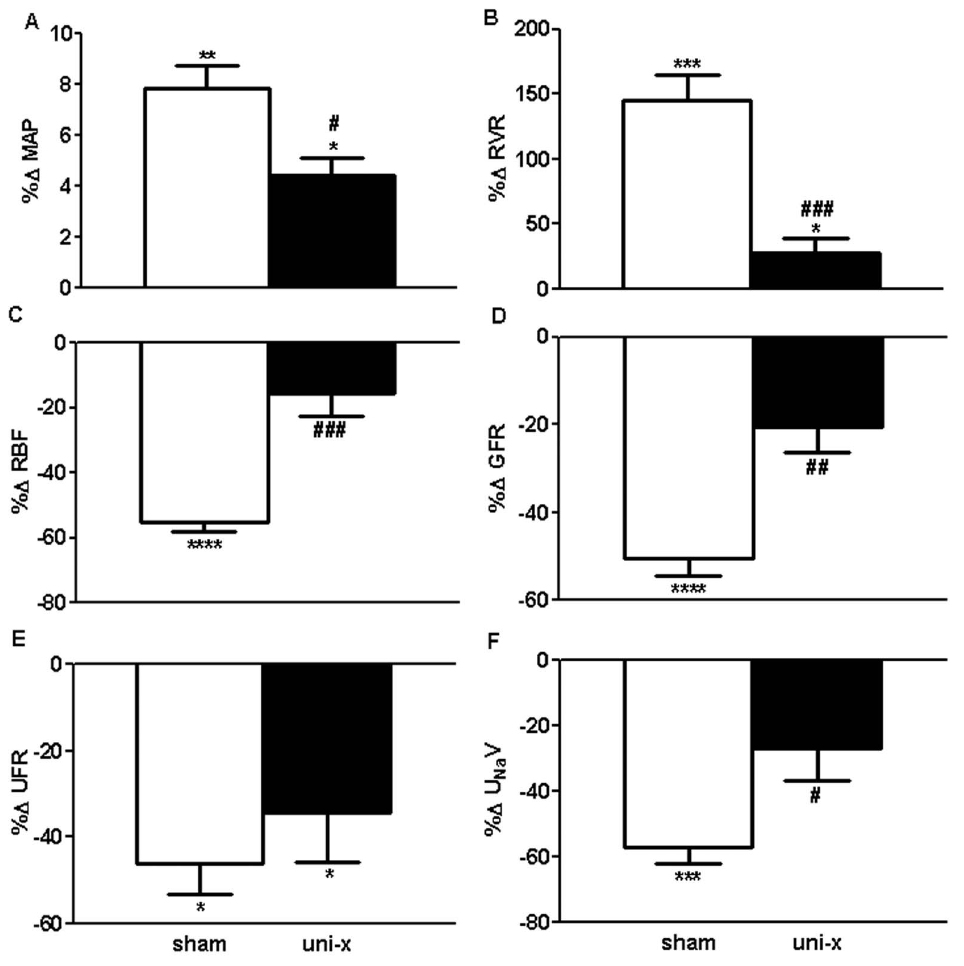
Figure 1. Cardiovascular and renal responses to intravenous infusion of low pressor dose angiotensin II (AngII) expressed as percentage change (% D ) from basal period 1 in sham and uni-x female sheep at 5 years of age (n=5/group). MAP, mean arterial pressure; RVR, renal vascular resistance; RBF, renal blood flow; GFR, glomerular filtration rate; UFR, urine flow rate; U Na V, urinary sodium excretion; all values except MAP are corrected for total kidney weight (gkw). Sham: white bars, uni-x: black bars, *P , 0.05, ***P , 0.001, ****P , 0.0001 from Bonferroni post-hoc test comparing responses of sham or uni-x animals to AngII infusion from their basal period 1. # P , 0.05, ## P , 0.01, ### P , 0.001 from student’s t-test comparing sham and uni-x. Values are mean 6 SEM.